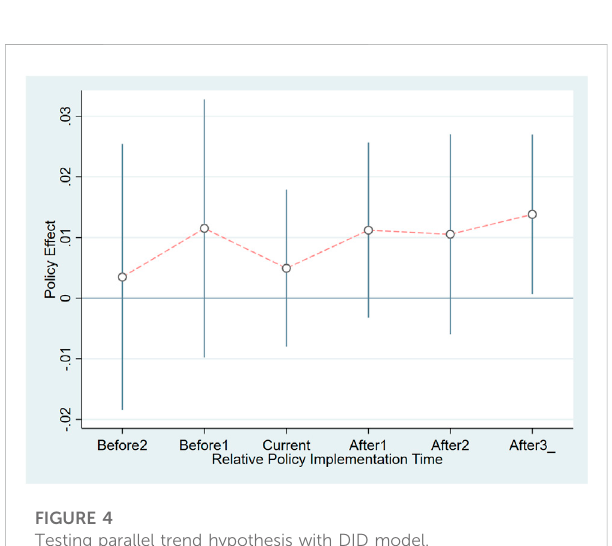
FIGURE 4 Testing parallel trend hypothesis with DID